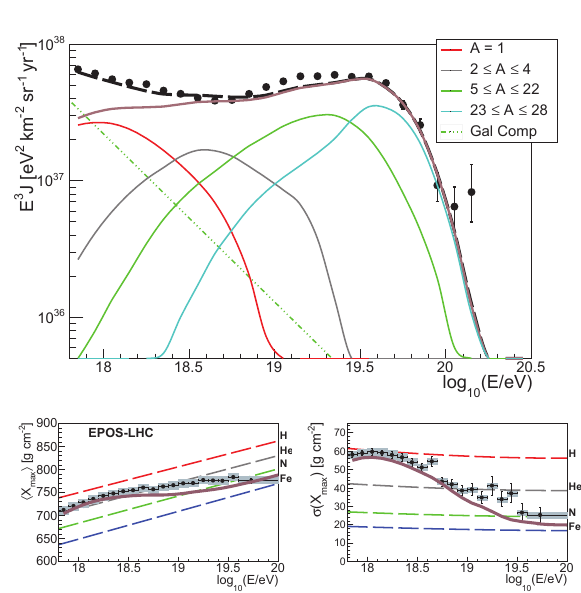
Figure 5. Top: All-particle best-fit scenario and partial spectra related to di ff erent detected mass groups compared to the mea- sured spectrum [37]. Bottom: Average (left panel) and standard deviation (right panel) of the experimental (black dots as reported in [38]) and expected (lines) X max